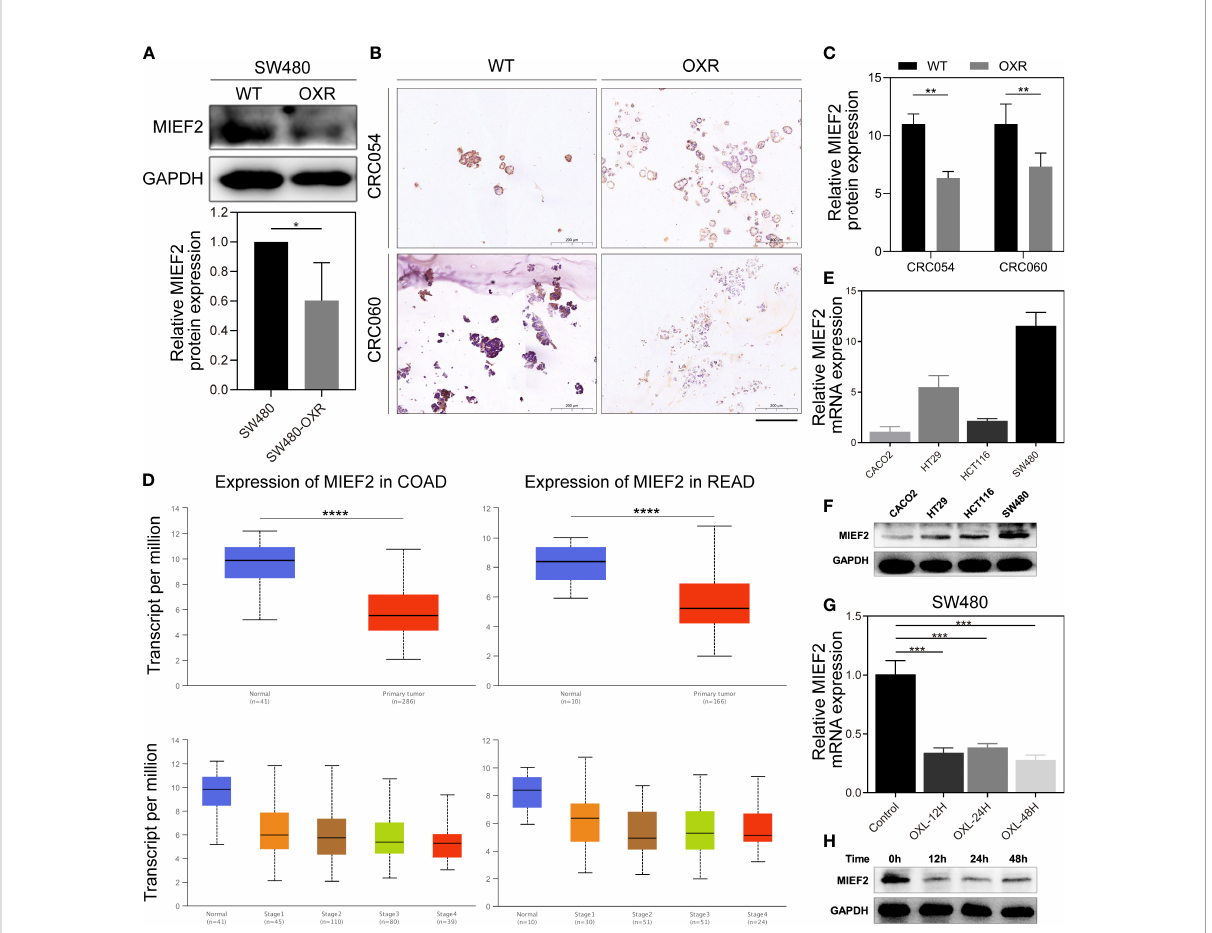
FIGURE 3 MIEF2 is involved in the CRC response to OXL. (A) The protein expression level of MIEF2 in SW480 and SW480-OXR was detected by western blotting analysis. Statistical analysis was performed using two-tailed unpaired t-test. * P <0.05 (mean ± SD, n = 3 repetitions). (B, C) The cytoplasmic expression of MIEF2 was determined by immunohistochemical staining of paraf fi n-embedded sections from CRC organoids (CRC054 and CRC060) and their OXL-resistant cohort, and the immunoreactivity score (IRS) showed low expression of MIEF2 in OXR. Statistical analysis was performed using one-way ANOVA. ** P <0.01 (mean ± SD, n = 3). (D) MIEF2 expression in colon adenocarcinoma (COAD) and rectum adenocarcinoma (READ) was analyzed in the UALCAN database, and the results suggested that MIEF2 expression was decreased in CRC. Statistical analysis was performed using Student ’ s t-test. **** P <0.0001. (E, F) Expression of MIEF2 in SW480 in response to OXL treatment was determined by qPCR and western blotting analysis. Induction of MIEF2 mRNA expression at each time point was expressed as means ± SD (n = 3). Statistical analysis was performed using two-tailed unpaired t-test. *** P <0.001. (G, H) The basal expression levels of MIEF2 in CRC cell lines (Caco2, HT29, HCT116, SW480) were determined by qPCR and western blotting